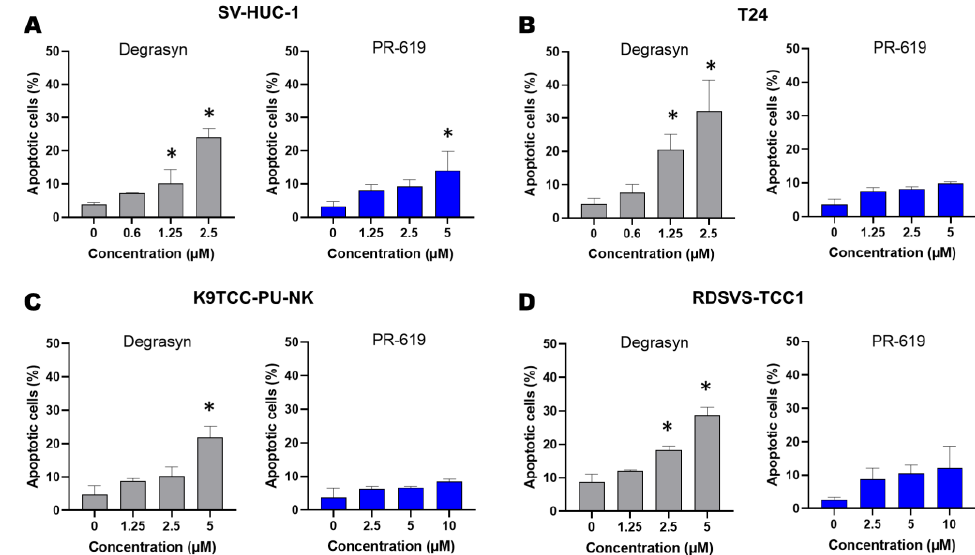
Figure 6. Evaluation of apoptosis induced by Degrasyn and PR-619. Percentage of apoptotic cells after 24 h exposure to increasing concentrations of Degrasyn and PR-619 in ( A ) SV-HUC-1, ( B ) T24, ( C ) K9TCC-PU-NK, and ( D ) RDSVS-TCC cell lines (Annexin V-FITC/PI staining). Values are expressed as the means ± standard deviations (SD) of three independent experiments. * Considered significant in comparison to control ( p < 0.05).